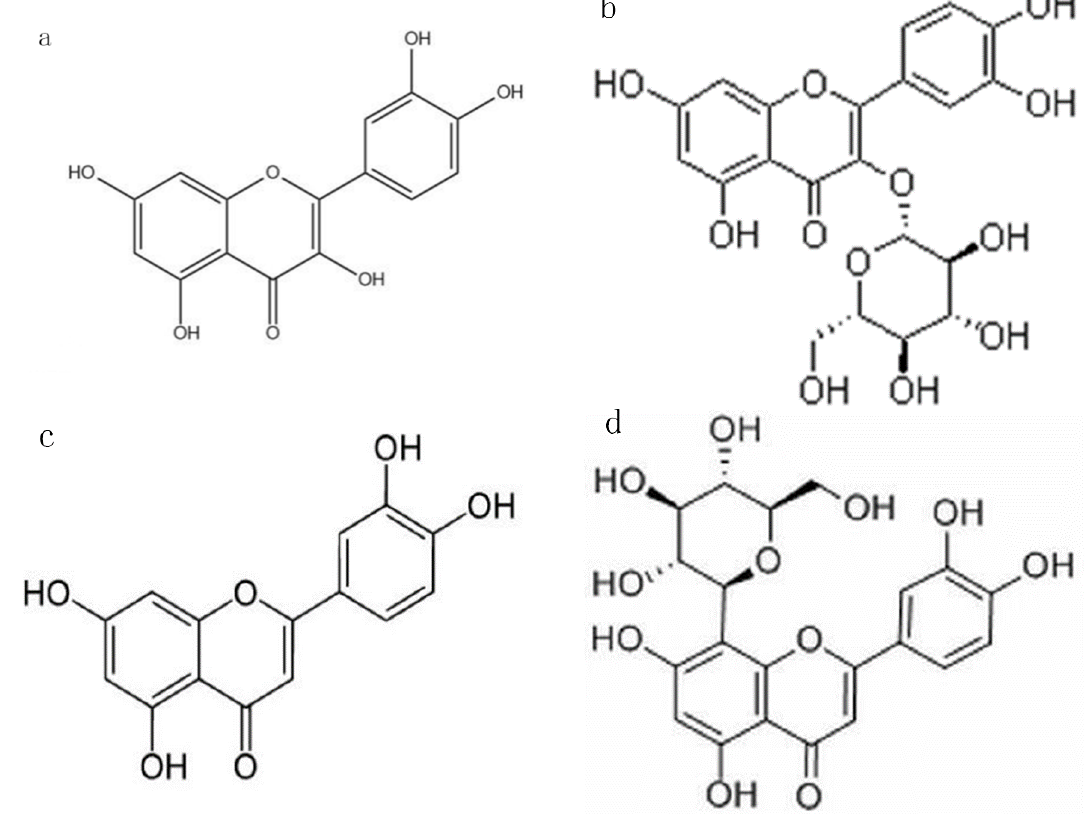
Figure 1. Structure of several flavonoids: ( a ) quercetin, ( b ) isoquercitrin, ( c ) luteolin, and ( d ) orien- tin.